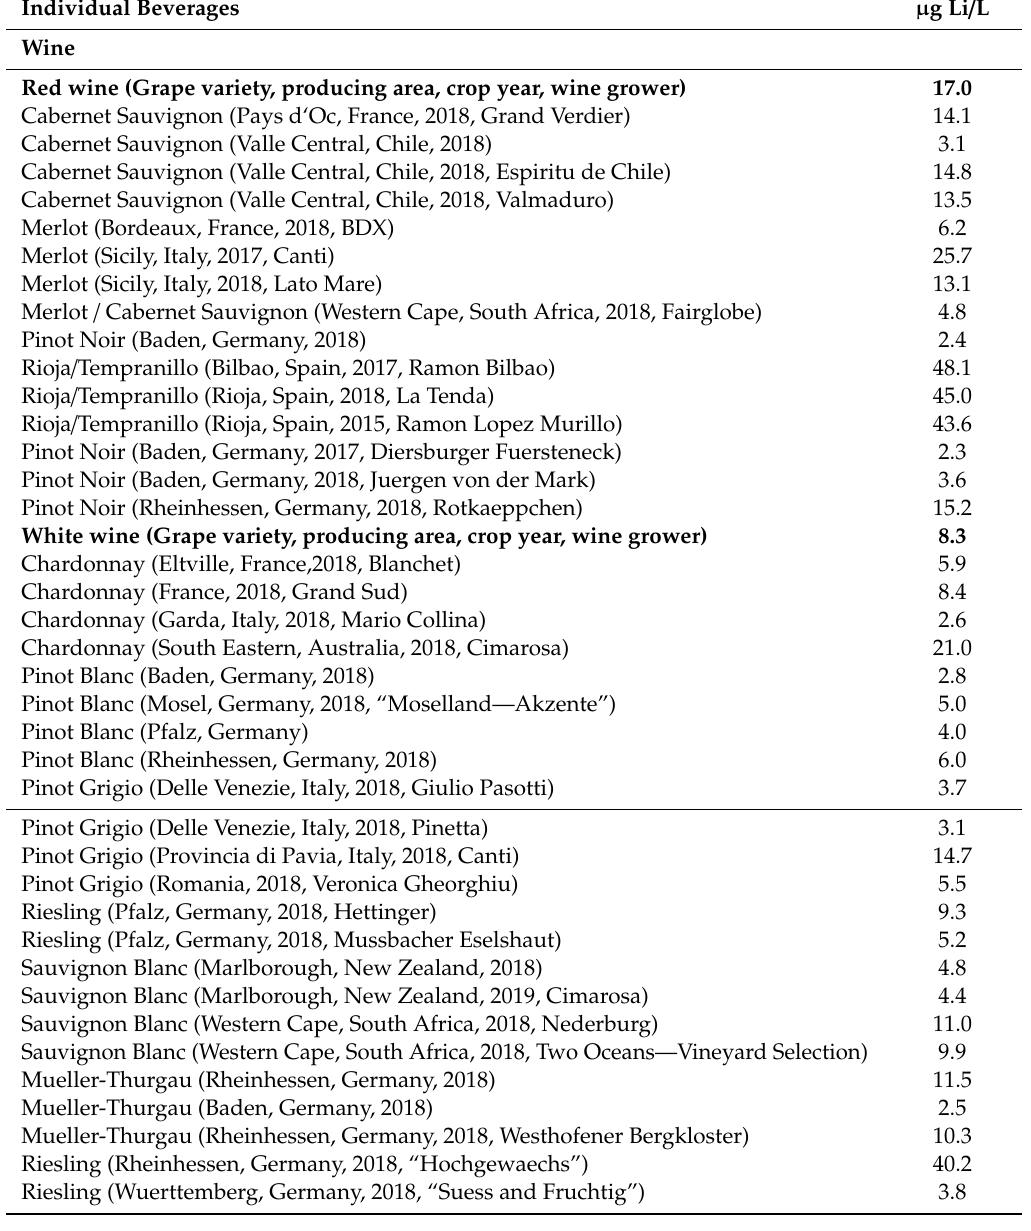
Table 4. Lithium concentrations ( µ g Li / L) of beer and wine. Wine samples were grouped in red and white wine. Li concentrations were measured by inductively coupled plasma mass spectrometry